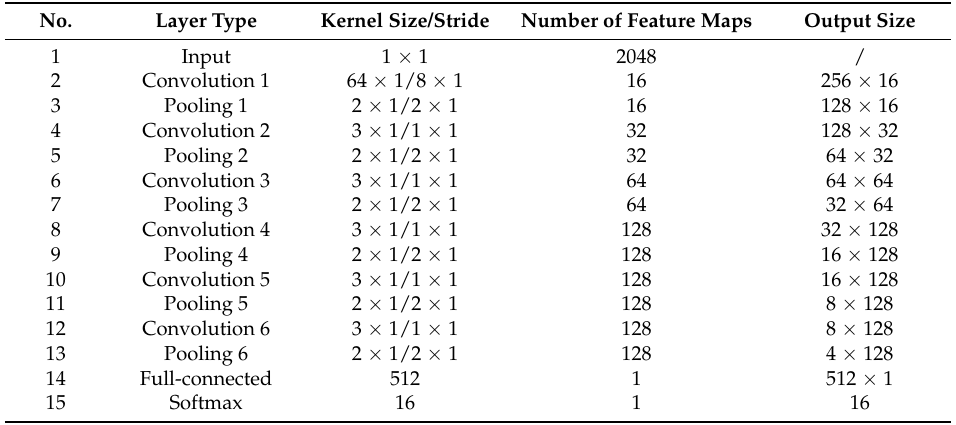
Table 4. Parameters of the CNN